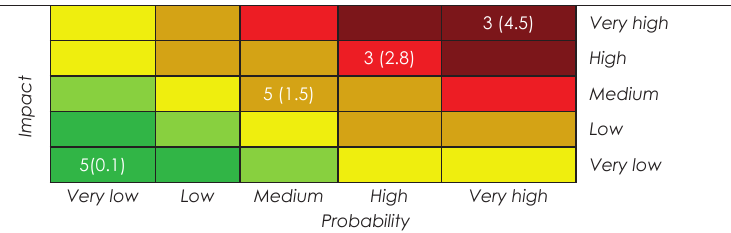
Table 13: Summary of risk P-I across the PLC in Case